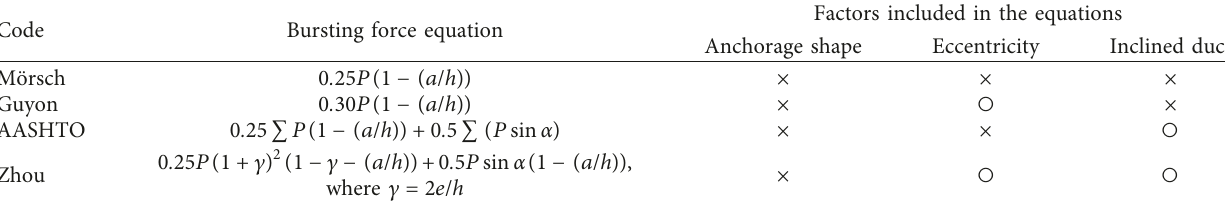
Table 1: Comparison of different bursting force equations.